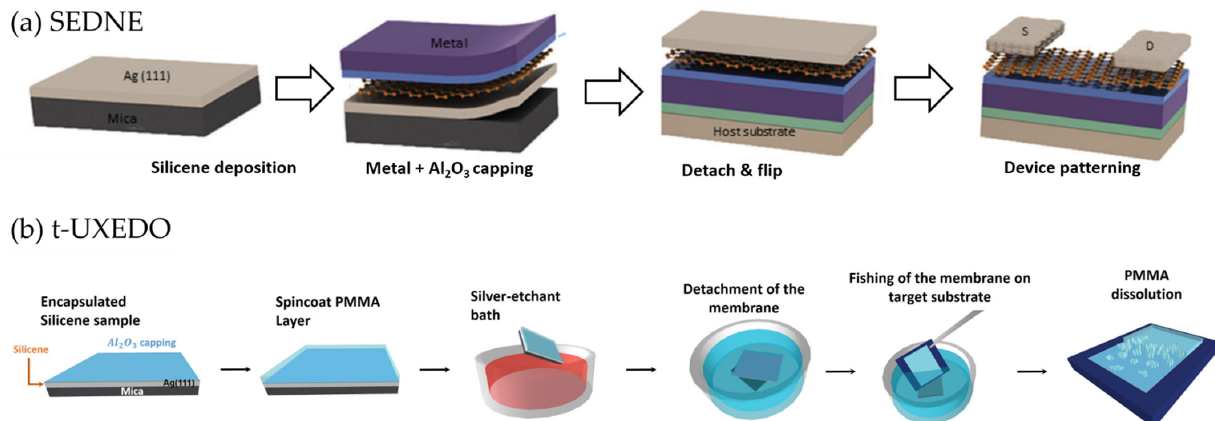
Figure 4. SEDNE and t-UXEDO processes. ( a ) Schematics of the SEDNE and s-SEDNE process developed for the manipulation of a silicene layer grown on Ag(111)/mica substrate. To facilitate the sample handling during the process steps, the robustness of the Al 2 O 3 -encapsulated silicene layer is strengthen via deposition of multilayer stacks made by dielectric (Al 2 O 3 , SiO 2 , etc.) and metal layers. Taking advantage of the mica cleavability, the metal/dielectric/silicene/Ag stack is detached from the substrate and flipped upside down. The pristine silver substrate is then lithographically patterned to create metal contacts aiming at measuring the electrical performances of the silicene-based FETs. Adapted with permission from Ref. [27] ( b ) Schematics of the t-UXEDO process. From left to right: A polymethyl methacrylate (PMMA) polymer layer is spin-coated on top of the encapsulated silicene. The sample is then immersed in a commercial potassium iodide/iodine solution for the etching of the metal substrate. Before the complete etching, the sample is immersed in a de-ionized water bath favoring the mica detachment. The PMMA/Al 2 O 3 /silicene membrane is then transferred onto an arbitrary substrate. The final step is the dissolution of the PMMA layer in acetone or toluene solution. Adapted with permission from Ref. [26].